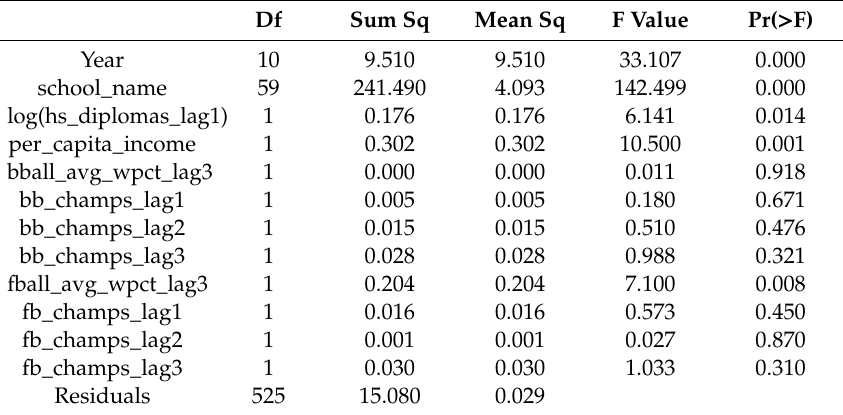
Table A3. ANOVA table for log(Donations).